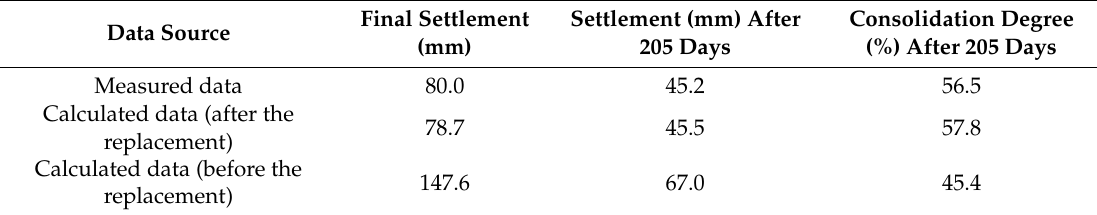
Figure 12. Comparison of the calculated consolidation curve before and after the replacement. Table 5. Calculation parameters of the replacement foundation of marine soft soil in